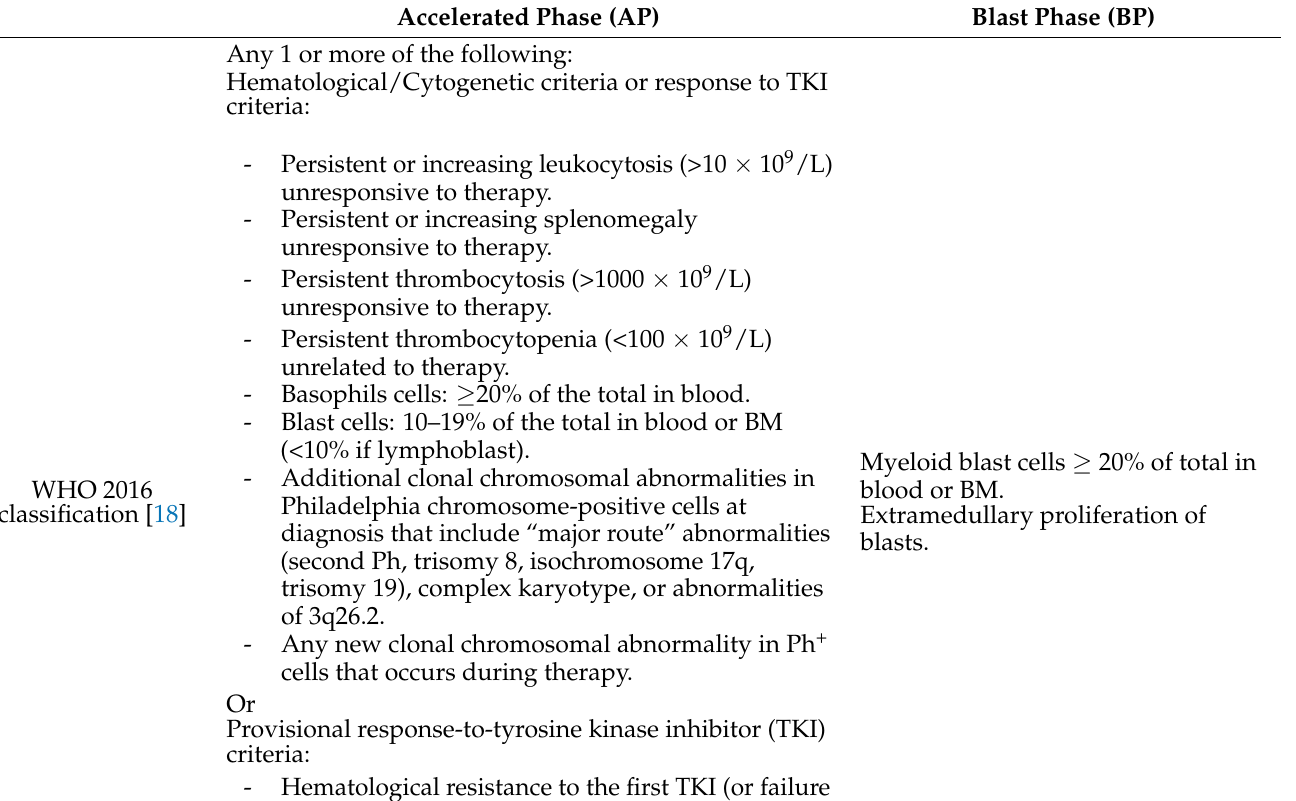
Table 6. Classification criteria for CML diagnosis. Accelerated Phase